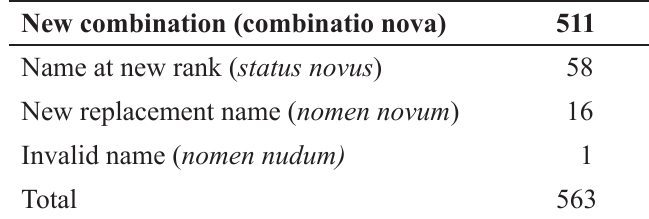
Table 8. Other nomenclatural